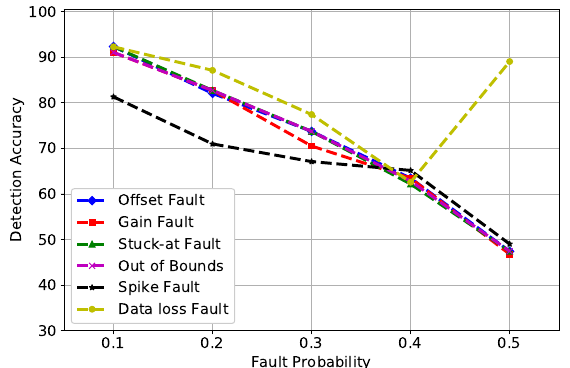
Figure 5. SGD detection accuracy of fault types.